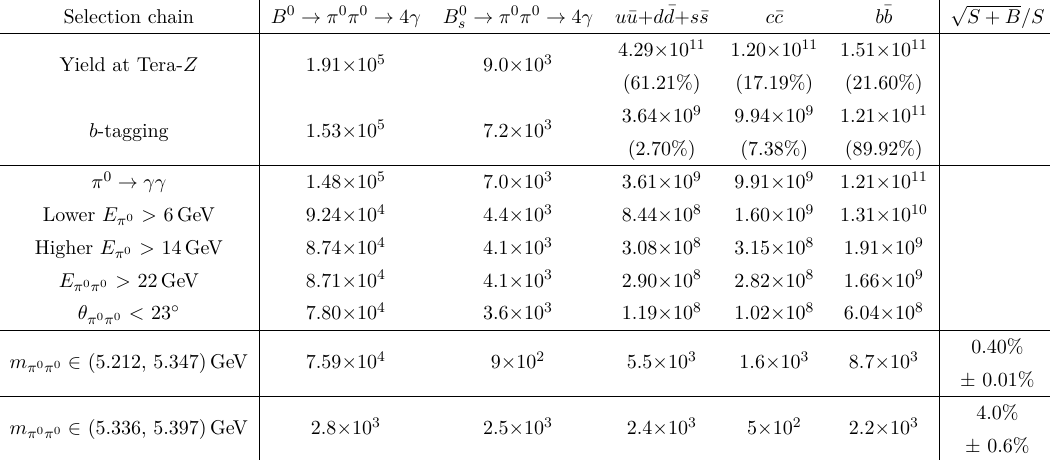
Table 4 . B 0 → π 0 π 0 and B 0 → π 0 π 0 yields at each step of the selection chain and their final s √ precision ( S + B/S ) when using the baseline b -tagging and ECAL energy resolution of 3% √ In the last two rows, selections on m are applied, the first one is for B 0 → π 0 π 0 , and the other π 0 π 0 one is for B 0 → π 0 π 0 s